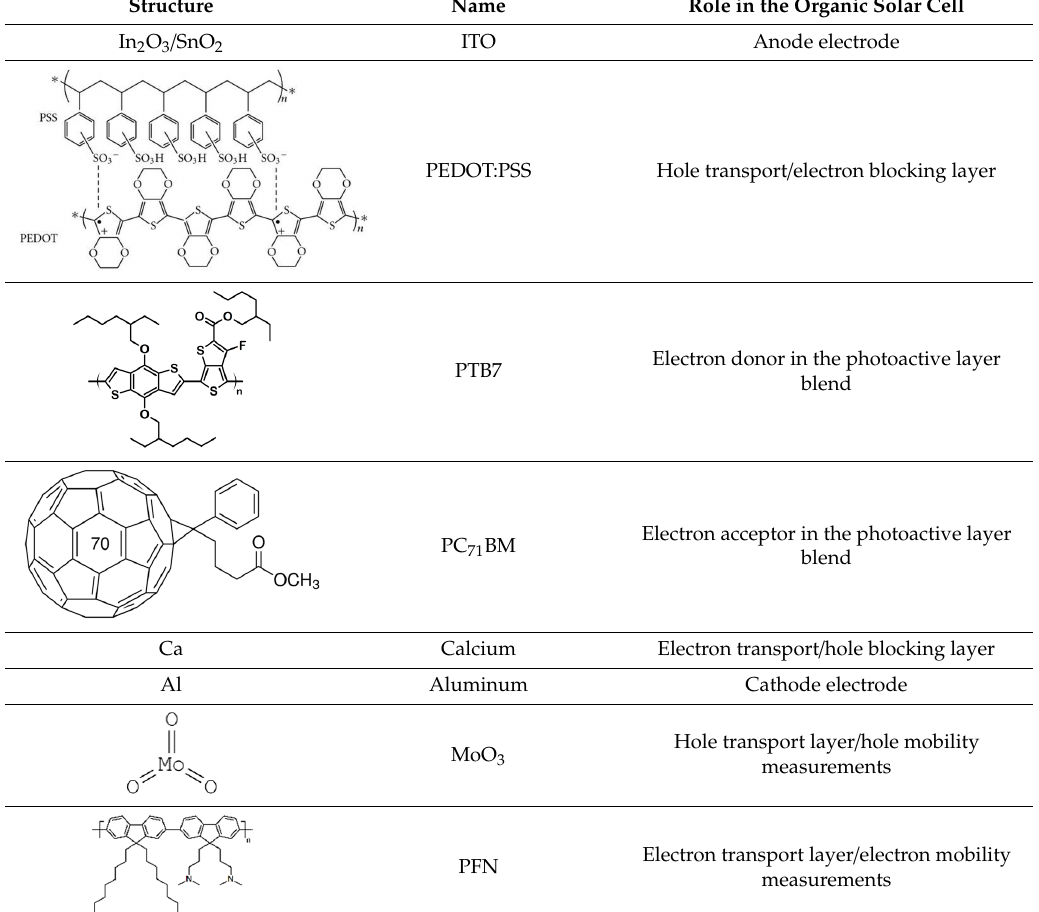
Table 1. Chemical structures/formulas of the compounds used in the fabrication of the organic solar cell devices.